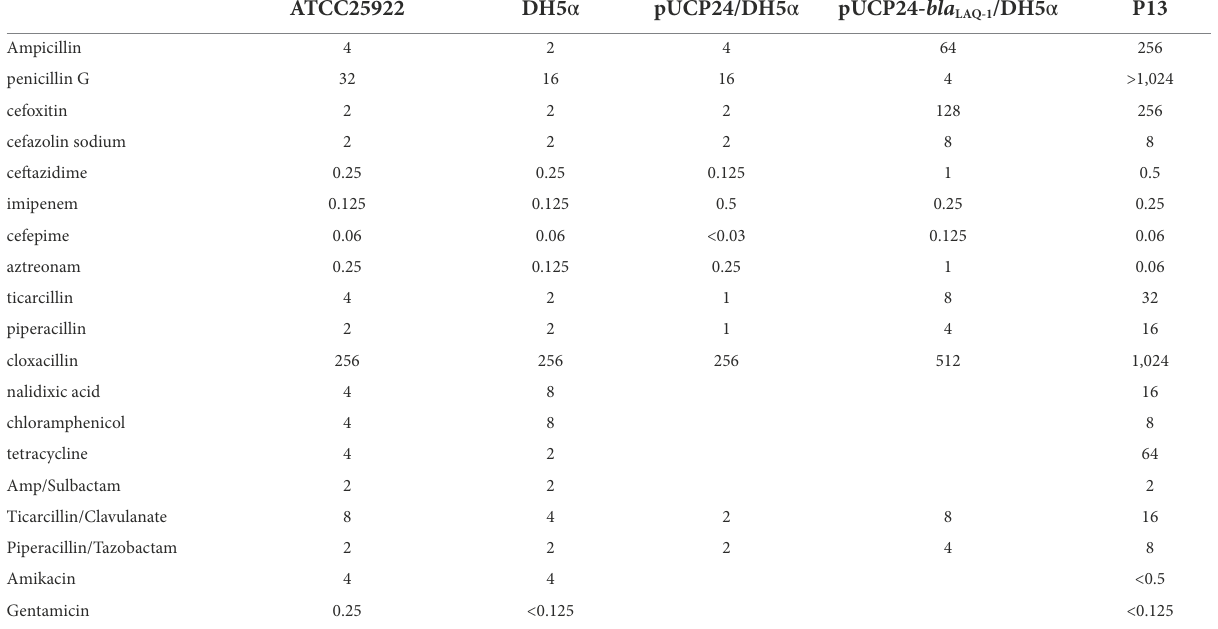
TABLE 3 MICs of 19 antimicrobials for the recombinants and the control strains ( μ